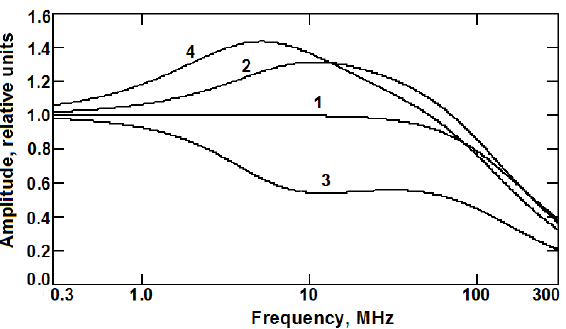
Fig. 3. AFC of the autodyne response transfer coefficients for a change in the amplitude of the oscillations obtained experimentally for AD on the Gunn diode if there is no synchronisation (curve 1 ) and if it is available for cases, when